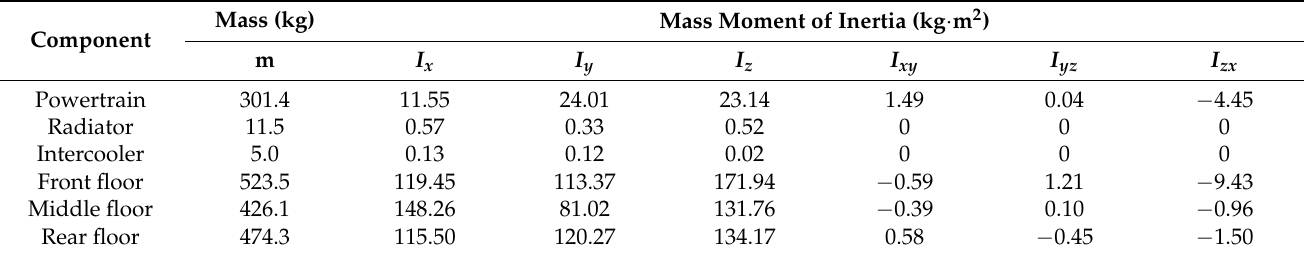
Table 1. Inertia properties used to construct the dynamic